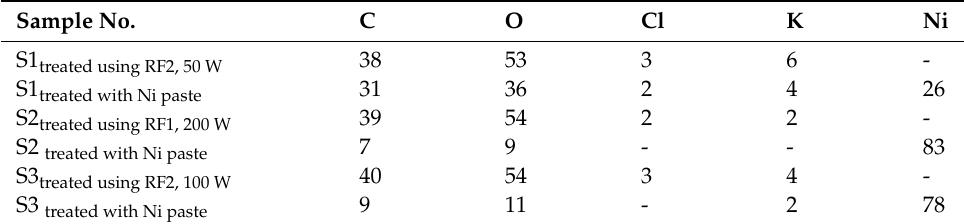
Table 5. Chemical composition (% wt).